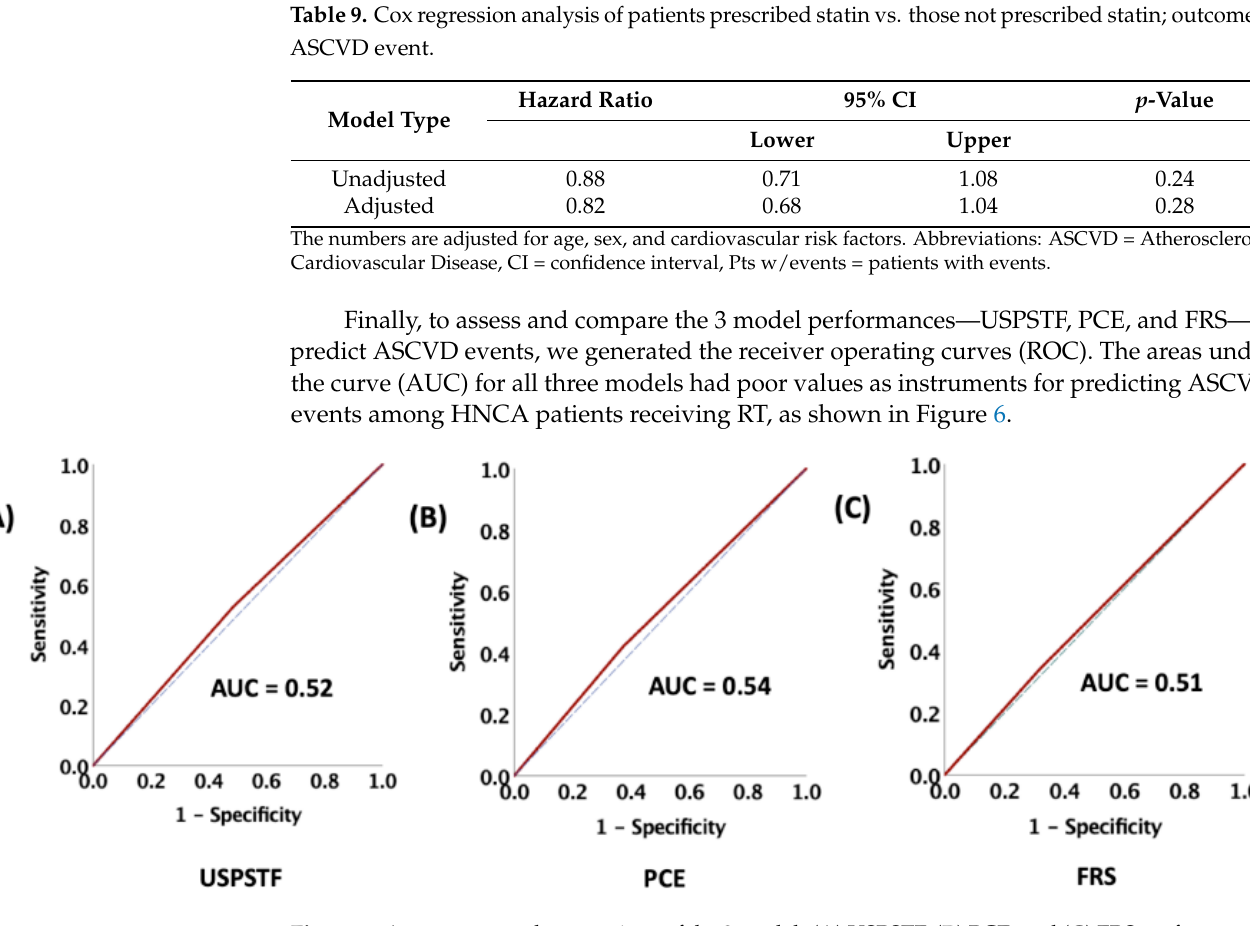
Figure 6. Assessment and comparison of the 3 model: ( A ) USPSTF, ( B ) PCE, and ( C ) FRS performances as an instrument to predict ASCVD events. ASCVD = Atherosclerotic Cardiovascular Disease, AUC = area under the curve.